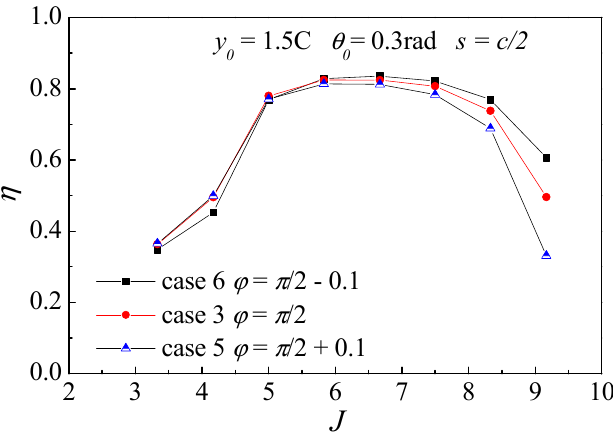
Figure 17. Comparison of wake vortices under four verification conditions (when the midpoint of the airfoil is at the equilibrium position).